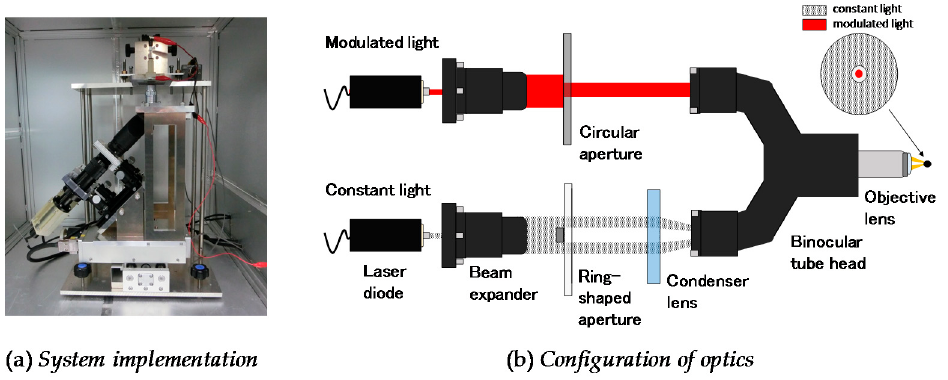
Figure 2. ( a ) Implementation of the measurement system in this study ; and ( b ) schematic configuration of